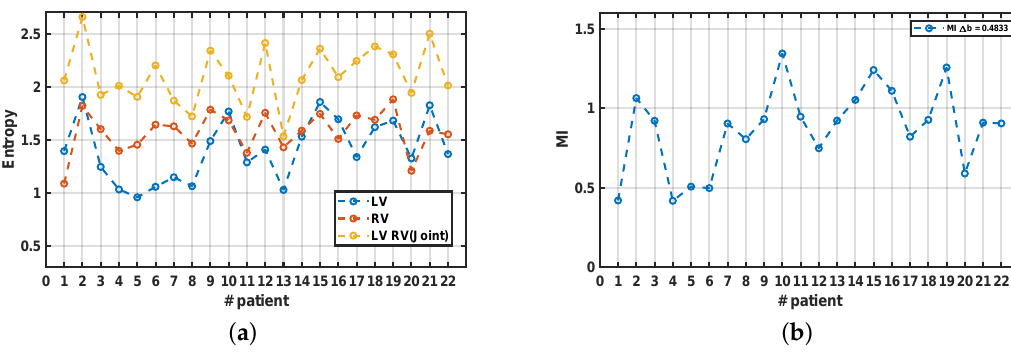
Figure 9. Measurements from Information Theory for cardiac signals in the patient database, using ∆ b = 0.4833. ( a ) Estimated Entropy for LV and RV, and their Joint Entropy. ( b ) Estimated